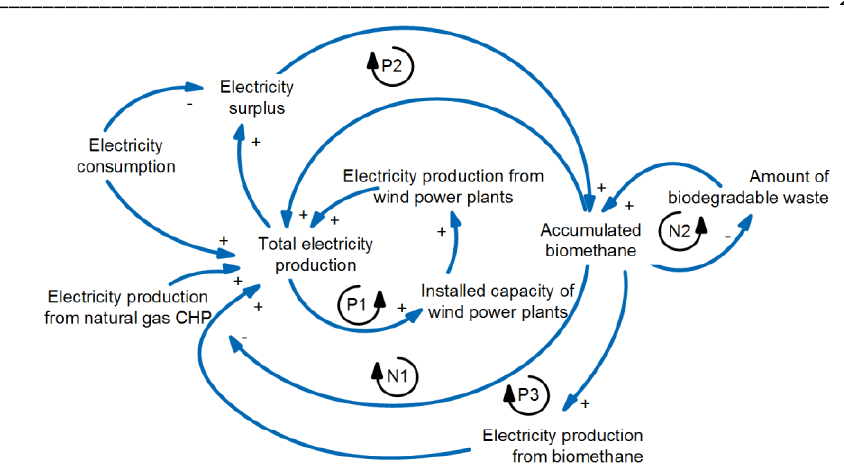
Fig. 2. Causal loop diagram for the conceptual system of renewable electricity accumulation using hydrogen to upgrade biogas to biomethane (P – positive causal loop, N – negative causal loop).